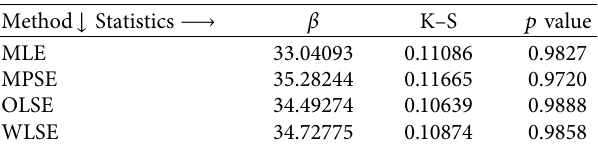
Figure 10: Te empirical CDF (a) and PP (b) plots for data set Table 18: Diferent estimators with K–S and its p values for data set II.